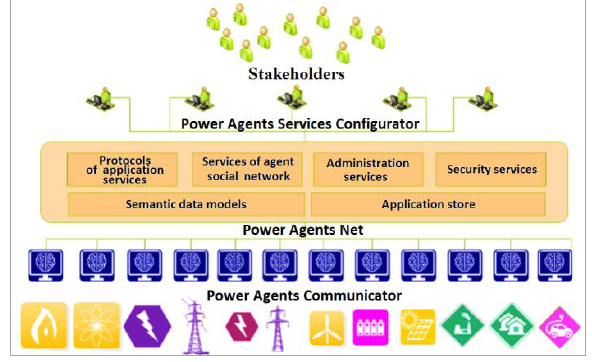
Figure 2. Power Agents Architect